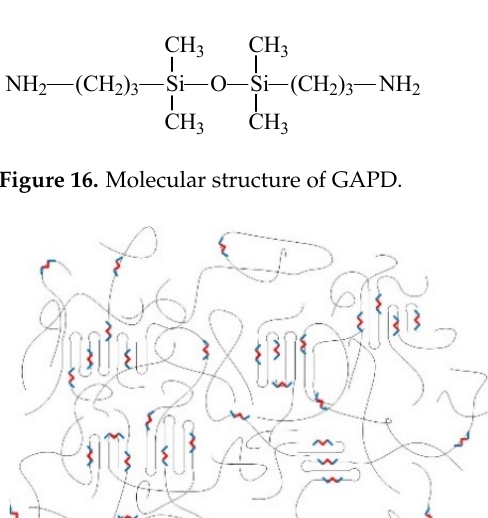
Figure 17. Structural model of modified materials.